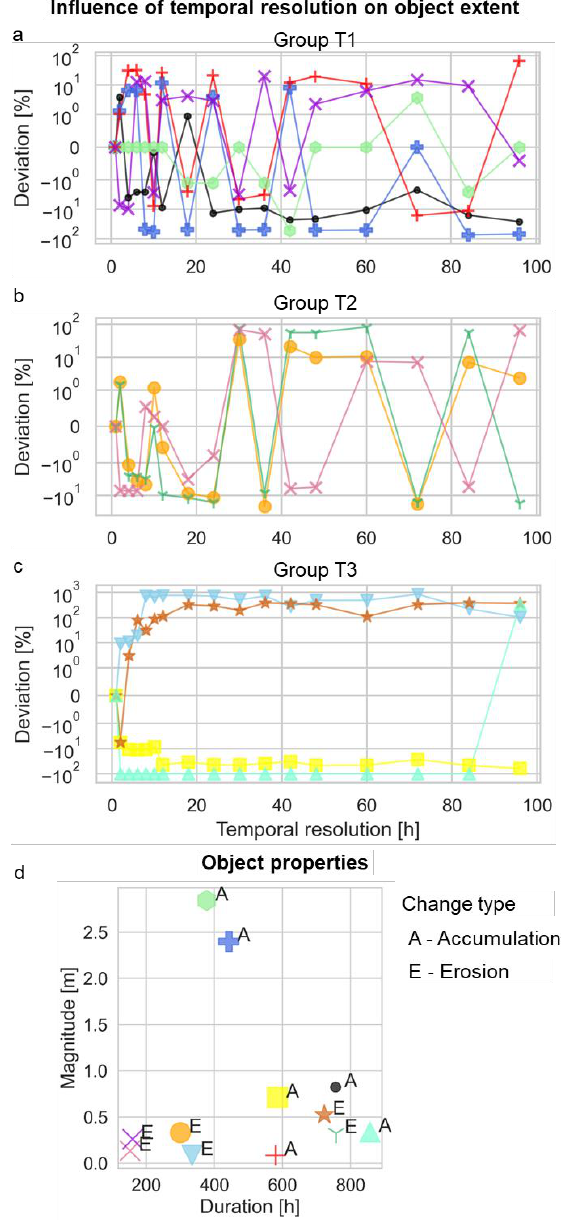
Figure 8. Relation of reduced temporal resolution to deviations in spatial extent compared to the reference objects obtained at highest input data resolutions. 4D objects-by-change are separated into three groups of similar scales and deviation behaviour (a-c). Note that the scales of y-axes are logarithmic, and only linear between -1 % and +1 %. Properties of individual objects are shown with distinct markers in